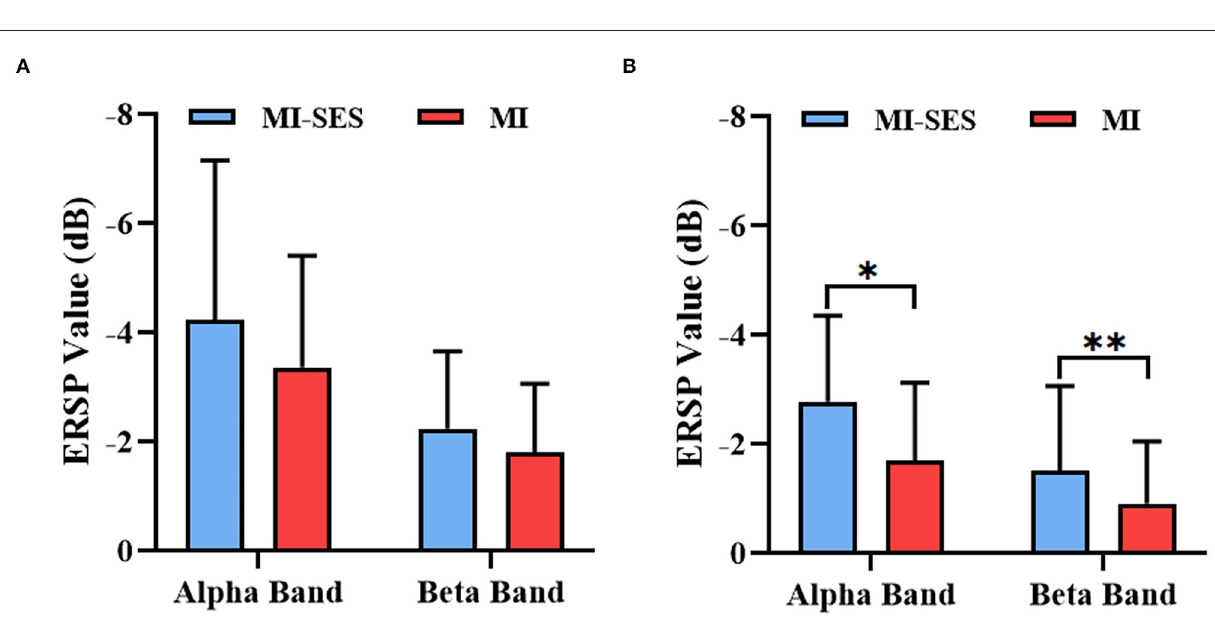
FIGURE 5 | Averaged ERSP values of alpha (8–13Hz) and beta (14–28Hz) rhythms during period [3 5] s for MI-SES and MI conditions. (A) High Performers group. (B) Low Performers group. Error bars represent the standard deviation. “*” indicates p < 0.05, “**” indicates p <